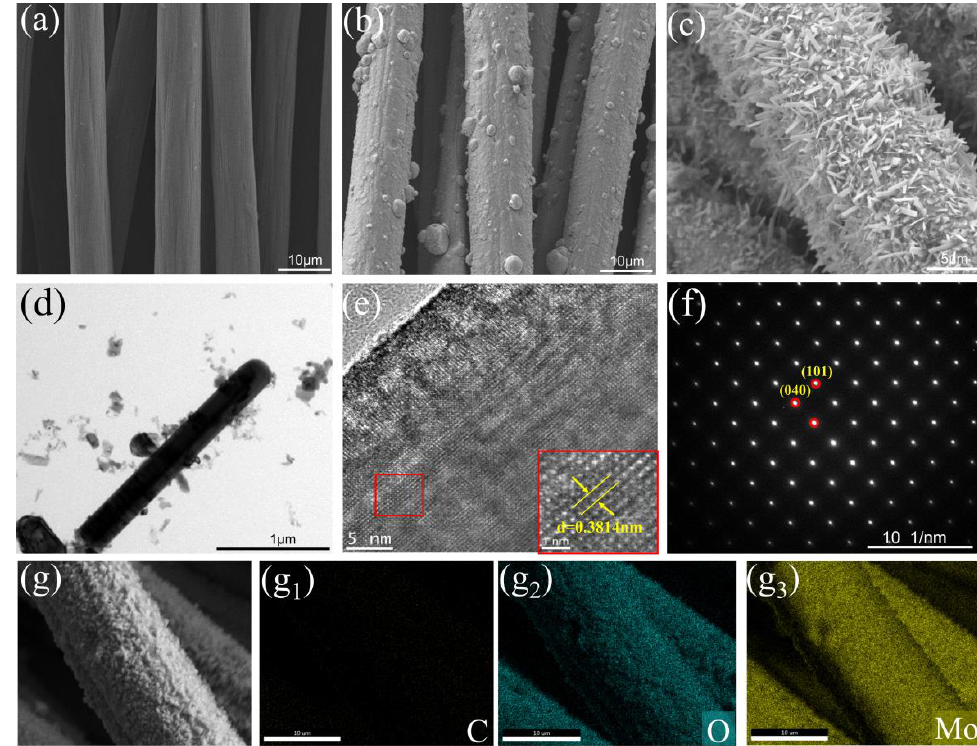
Figure 3. SEM image of ( a ) CFC, ( b ) Mo@CFC, and ( c ) α -MoO 3 @CFC heated at 600 °C for 20 min; ( d – g ) TEM image, HRTEM image, SAED image, and EDS mapping of C ( g1 ), O ( g2 ), and Mo ( g3 ) of the α -MoO 3 @CFC.